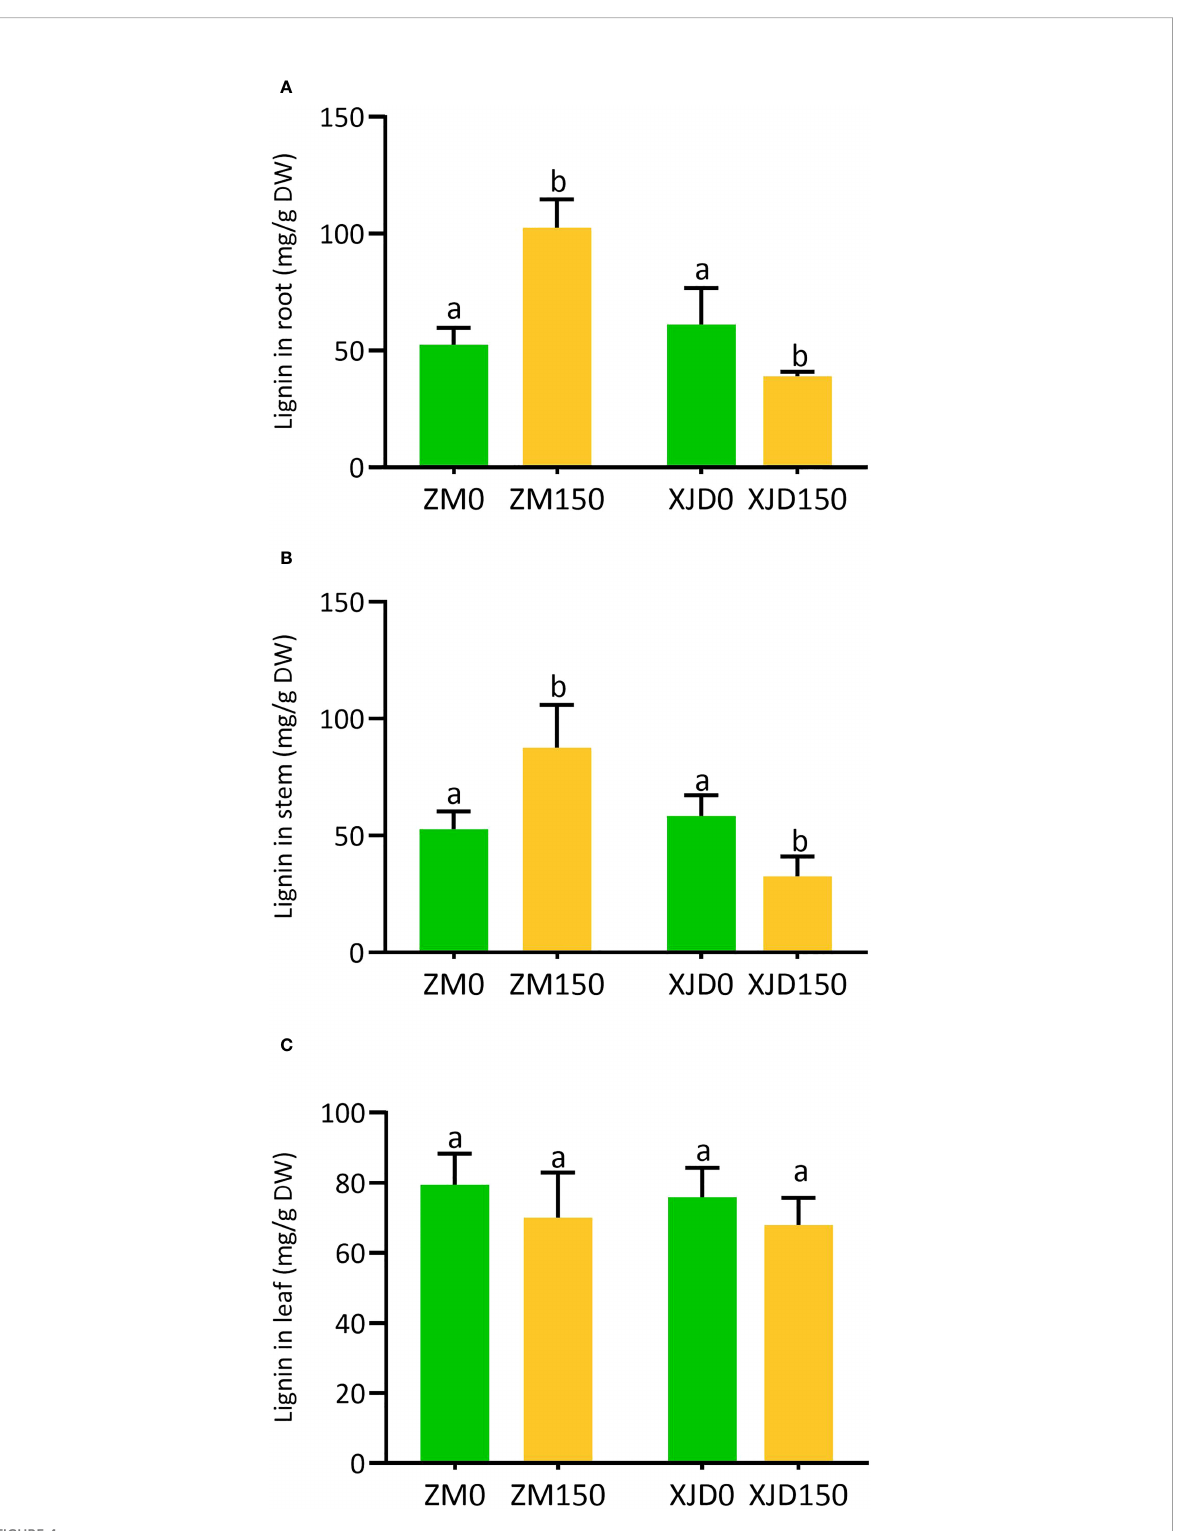
FIGURE 4 Lignin accumulation in two contrasting alfalfa under salt stress. Regulation of lignin in roots (A) , stems (B) , and leaves (C) of Zhongmu (ZM) and Xingjiang Daye (XJD) under salt stress. The numeric zero (0) indicates salt-untreated (control) plant, while the numeric 150 indicates 150 mM salt treatment. Different letters above the column bar indicate signi fi cant differences among the means ± SD of treatments (n = 3). Data were analyzed by ANOVA and Tukey ’ s tests at p ≤ 0.05 signi fi cant